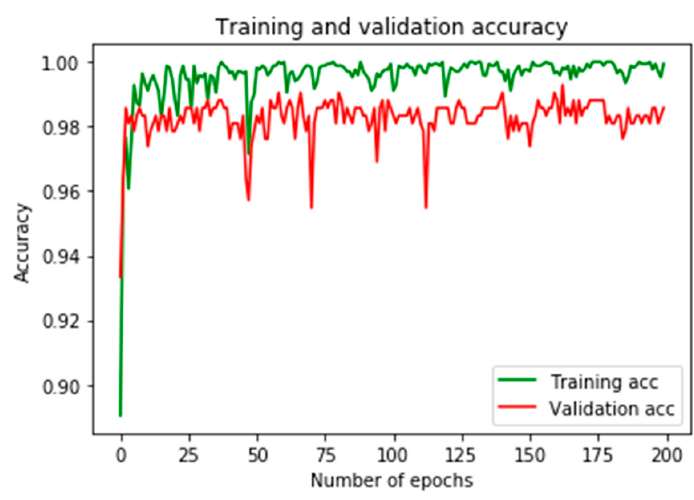
Figure 10. Showing training and validation accuracies using ResNet101 .